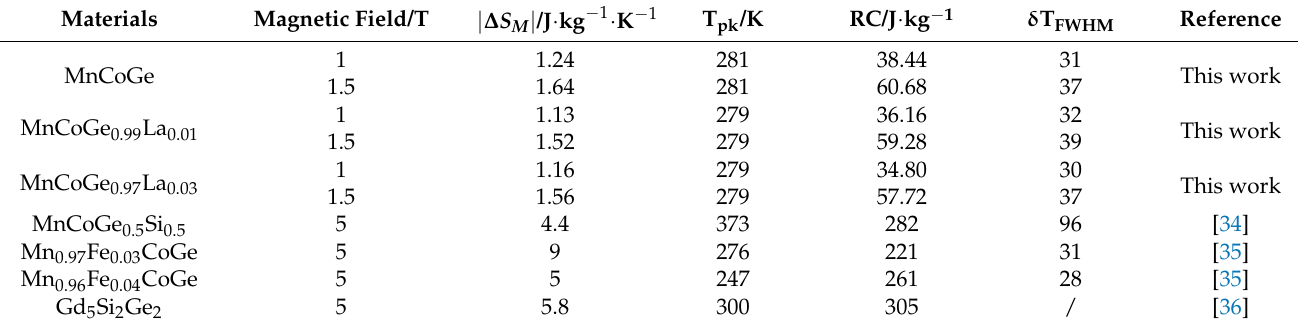
Table 5. The MCE of MnCoGe 1 − x La x alloys compared with other